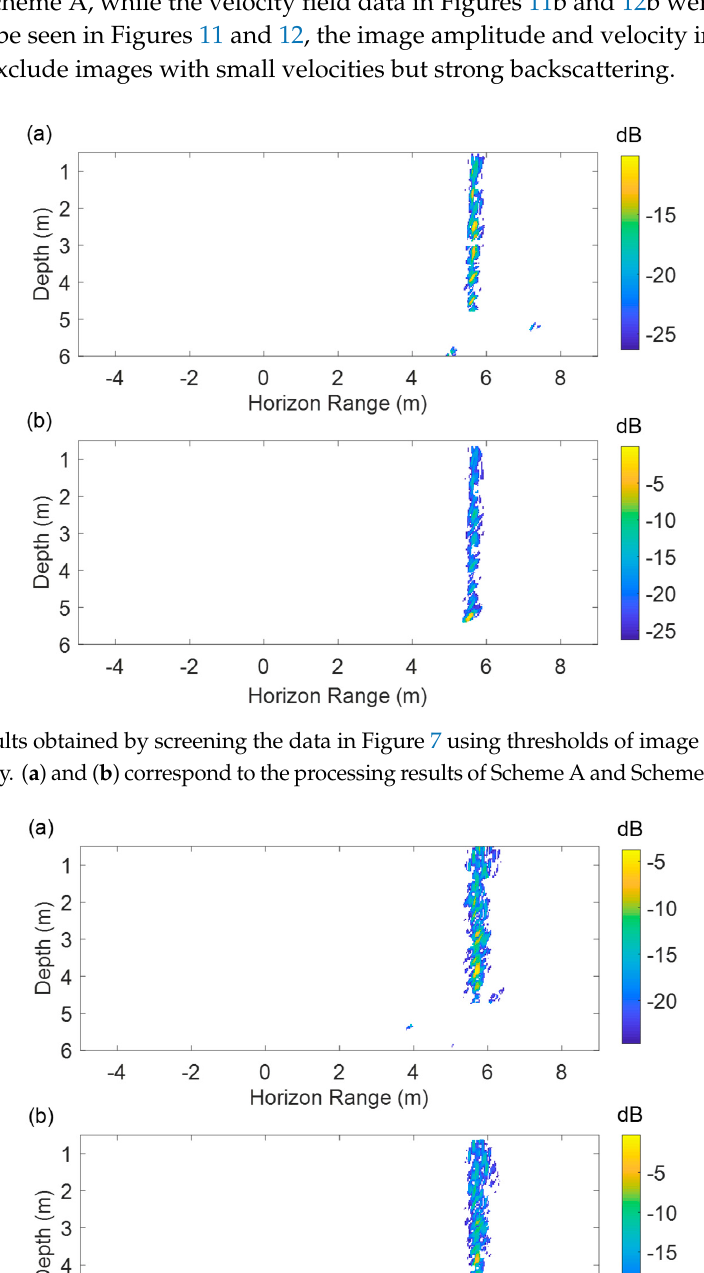
Figure 10. Comparison of echo intensities at two flow rate outputs.